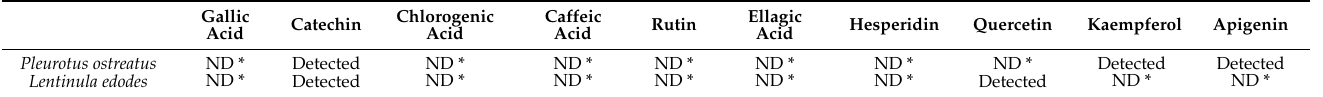
Table 2. Phenolic and flavonoid content molecules in Pleurotus ostreatus and Lentinula edodes extracts. Gallic Acid